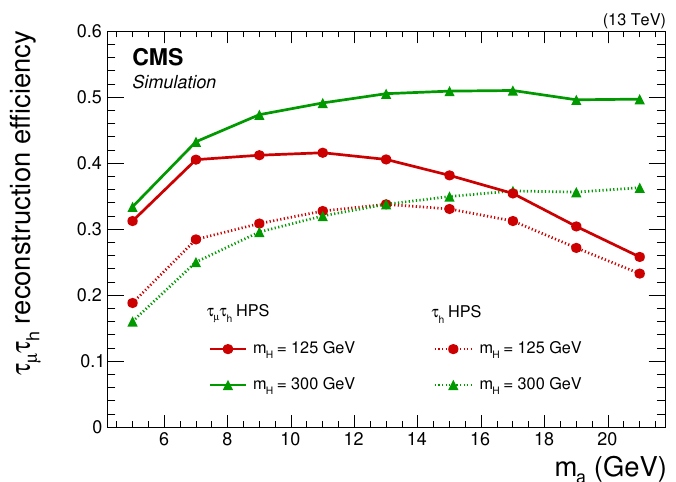
Figure 1 . The e(cid:14)ciency of the standard HPS (dashed lines) and (cid:28) in this search (solid lines) as a function of pseudoscalar boson mass for m 300 GeV (green). The events are required to have two reconstructed muons passing identi(cid:12)cation and isolation criteria. The e(cid:14)ciency is measured by additionally requiring a third muon pass- ing identi(cid:12)cation requirements and a (cid:28)